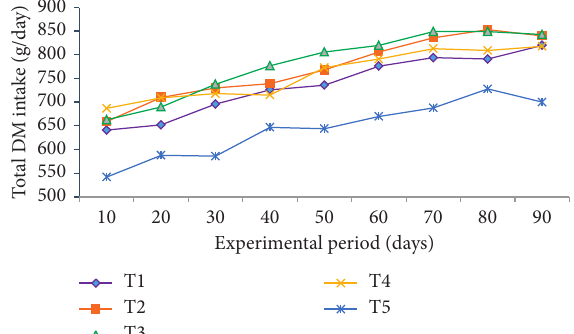
Figure 1: Trends of total DM intake during the experimental period of Bonga lambs fed on Rhodes grass hay basal diet and supplemented with dried mulberry and Vernonia mixed leaves’ meal substituting noug seed cake of concentrate mix at different levels. T1 � Rhodes grass hay ad libitum +100% concentrate mix; T2 � Rhodes grass hay ad libitum +75% noug seed cake (NSC) and 25% dried mulberry and Vernonia mixed leaves’ meal; T3 � Rhodes grass hay ad libitum +50% NSC and 50% dried mulberry and Vernonia mixed leaves’ meal; T4 � Rhodes grass hay ad libitum +25% NSC and 75% dried mulberry and Vernonia mixed leaves’ meal; T5 � Rhodes grass hay ad libitum +100% dried mulberry and Vernonia mixed leaves’ meal.